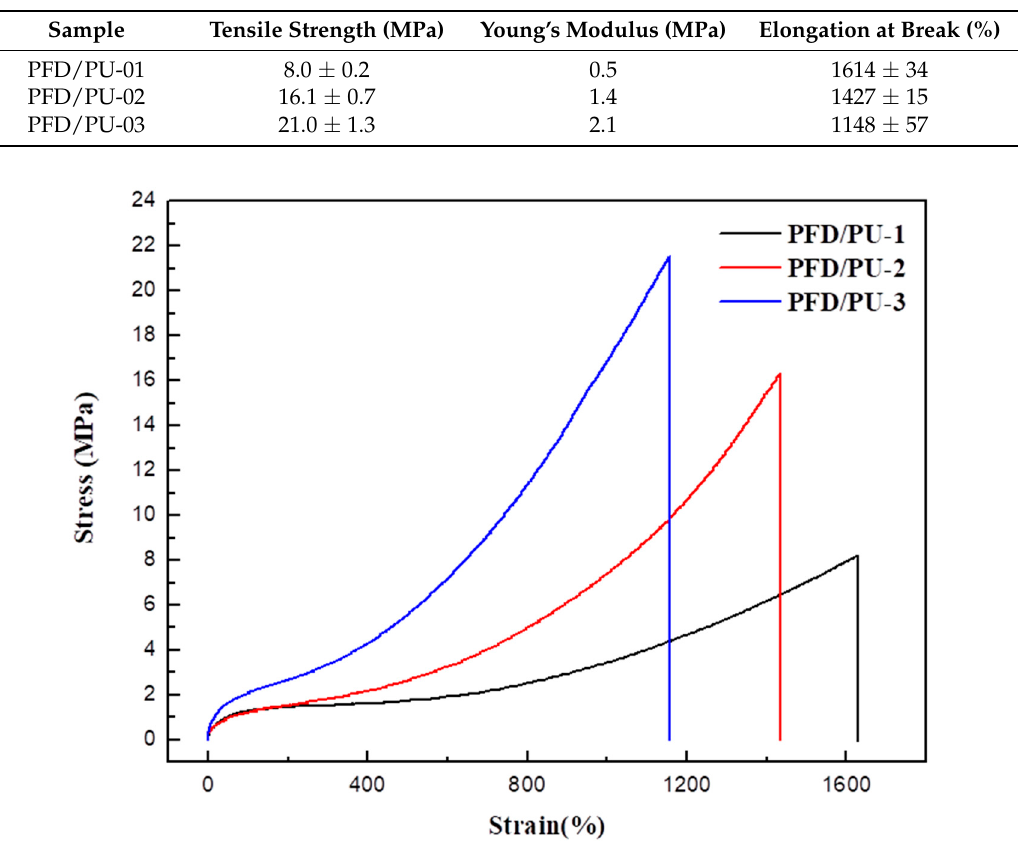
Figure 16. Tensile properties of PFD/PUs.